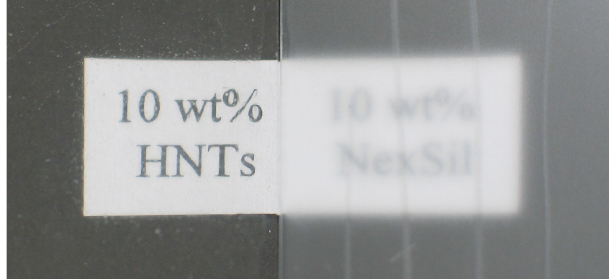
Figure 2. Photographs taken through a sample containing 10 wt% HNTs ( left ) and a sample containing 10 wt% silica spheres with a diameter of 85 nm ( right ). Both films are 16 µm thick. Clearly, the film containing HNTs still is moderately transparent.